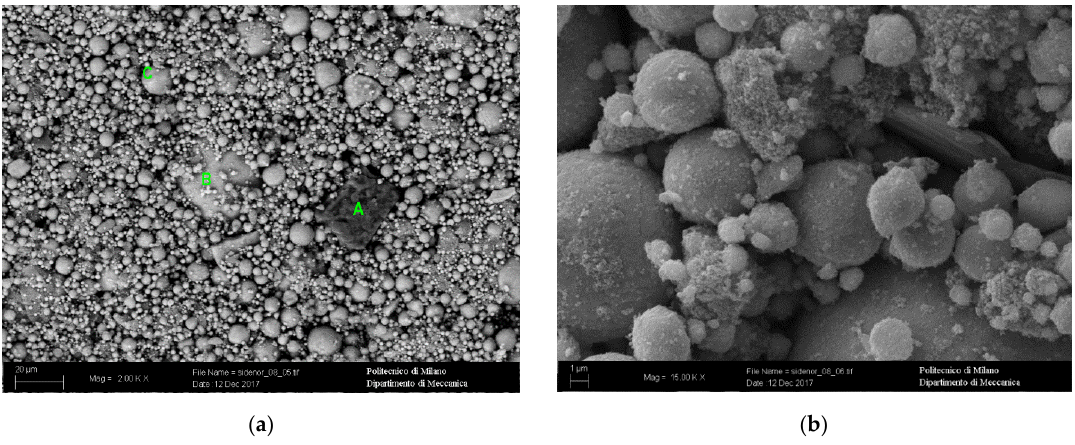
Figure 7. SEM–secondary electron (SEM-SE) ( a ) and SEM–back-scattered electron (SEM-BSE) ( b ) micrographs of as-received oxy-cutting fines. Table 6. SEM-EDS analysis of as-received oxy-cutting fines.